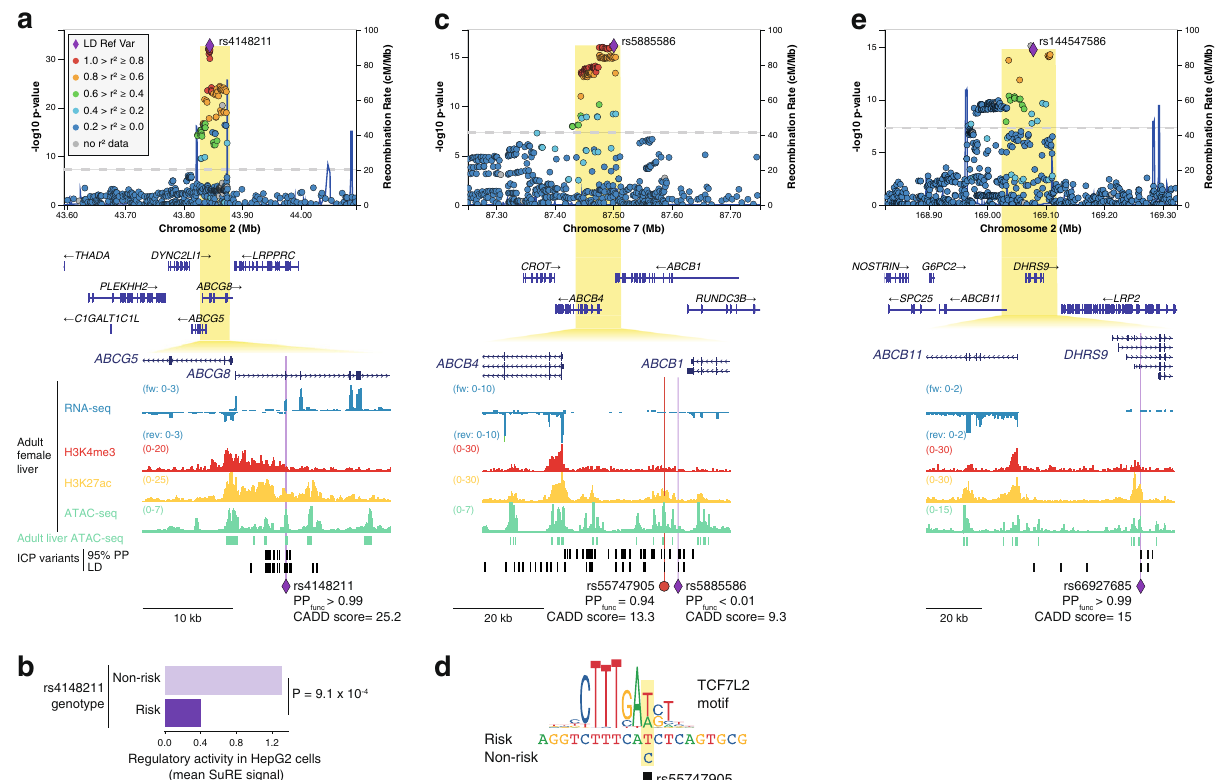
Fig. 4 Three ABC transporter gene loci are associated with intrahepatic cholestasis of pregnancy (ICP). a , c , e LocusZoom 61 plots showing the association signals at ABCG8 , ABCB1/4 , and DHRS9 , respectively. The LocusZoom plots are as per Fig. 3 and association testing was performed as described in Fig. 1. At each locus, a single noncoding variant was prioritized as likely causal following the strategy outlined in Fig. 2. All epigenomic and transcriptomic datasets shown were retrieved from ENCODE 18 . Adult liver ATAC-seq peaks track (green regions) corresponds to regions accessible in at least two out of four ENCODE adult liver ATAC-seq (see Methods). 95% PP ICP variants, variants within the 95% genetic credible set in the ICP meta- analysis. LD ICP variants, variants with EUR r 2 > 0.8 with the meta-analysis lead variant. PP func , functional posterior probability calculated using PAINTOR 17 . CADD, combined annotation-dependent depletion. a Zoomed inset shows a coding variant at ABCG8 overlapping a hepatic transcriptional enhancer, as revealed by strong H3K27ac enrichment and accessible chromatin in adult female liver tissue. Metadome analysis did not suggest that this variant affects protein function (see Supplementary Fig. 7). b Allele-speci fi c effect of the prioritized risk variant rs4148211, assessed by Survey of Regulatory Elements (SuRE) in HepG2 cells 31 . The results suggest that the risk variant associates with decreased transcriptional activity. Mean signal and two-sided Wilcoxon rank-sum test. Previously determined 5% false-discovery rate threshold: P < 0.00173121 31 . Source data are provided as a Source Data fi le. c , e Zoomed insets show two prioritized regulatory risk variants for ICP: one affecting a hepatic enhancer between ABCB1 and ABCB4 ( c ), and one affecting a hepatic enhancer in an intron of DHRS9 ( d ). We note however that DHRS9 is not expressed in liver tissue, as shown in the strand-speci fi c RNA-seq tracks. In contrast, ABCB11 is highly expressed in this tissue making it a likely effector transcript in this